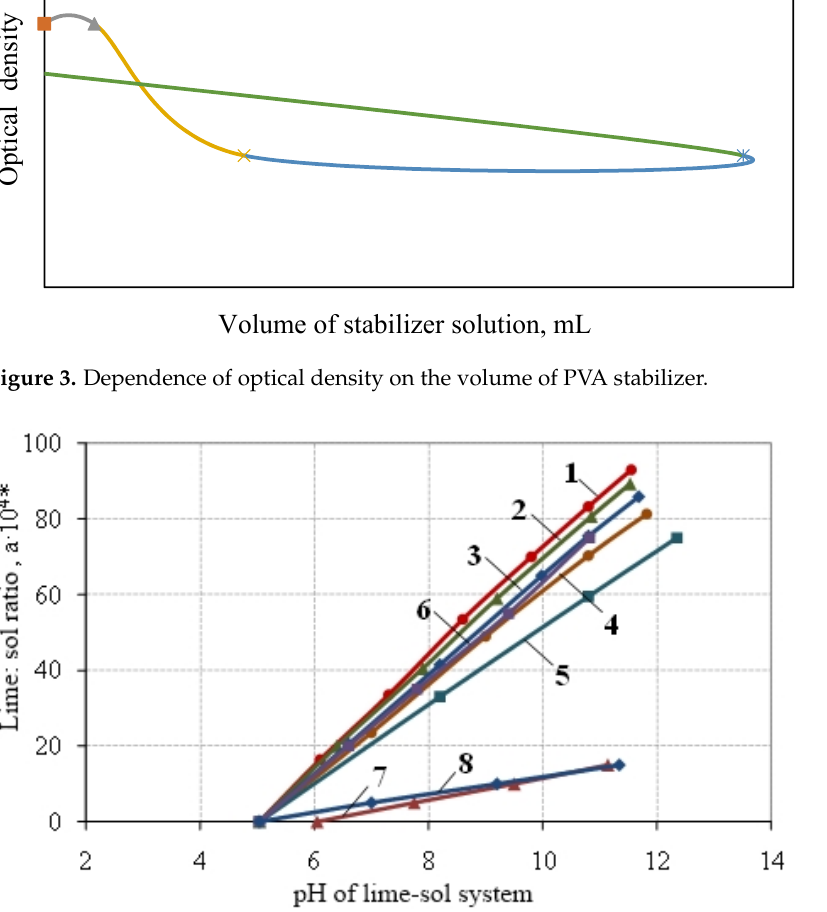
Table 2. The values of the radius of the sol particles depending on the aging period. Silica Sol Aging Time, Days